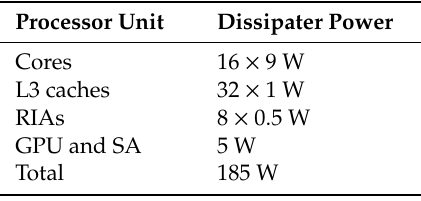
Table 2. Power distribution among chip units for the default